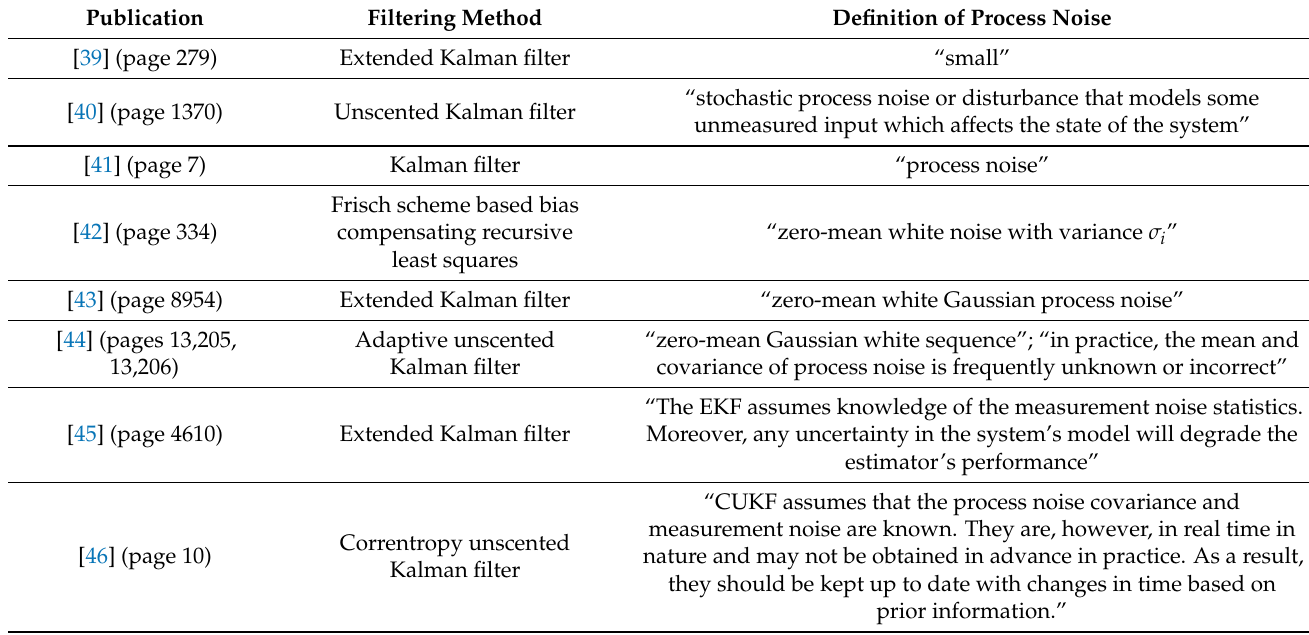
Table 1. Process noise in SOC